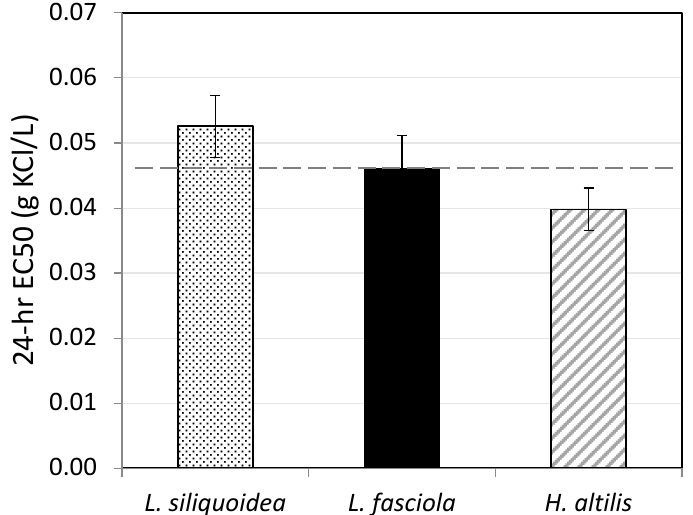
Figure 3. Twenty-four-hour KCl EC50s for glochidia from Lampsilis siliquoidea , L. fasciola , and Hamiota altilis . All tests were conducted in moderately hard reconstituted water (hardness 80–90 mg/L) at 20 °C. The dashed line indicates the geometric mean of the EC50s for the three species. Error bars represent 95% confidence limits.